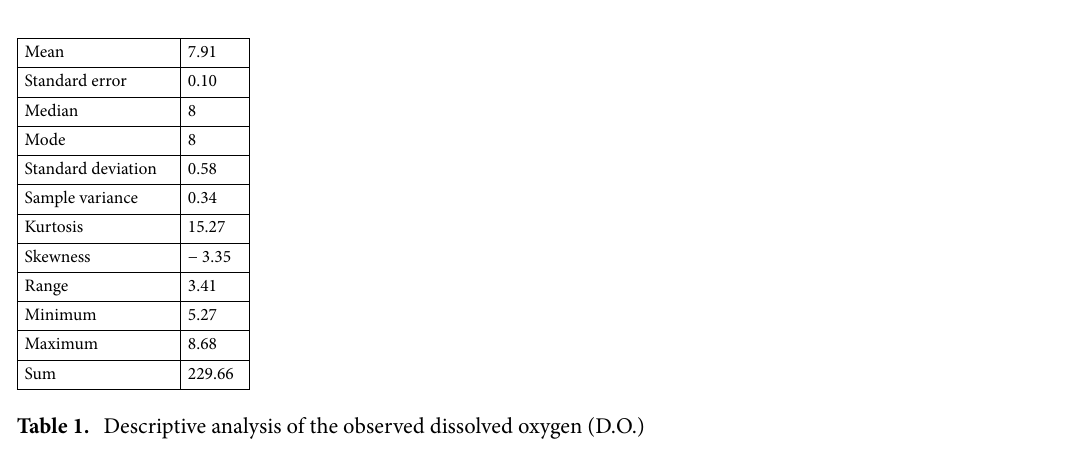
Figure 1. Location of Fei-Tsui Reservoir and sampling sites.